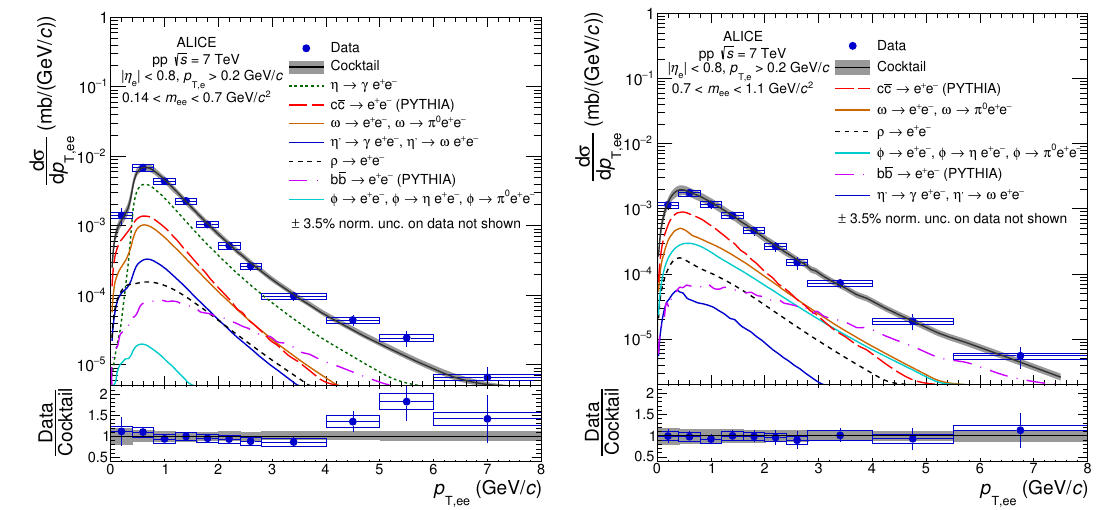
p s = 7 TeV in the